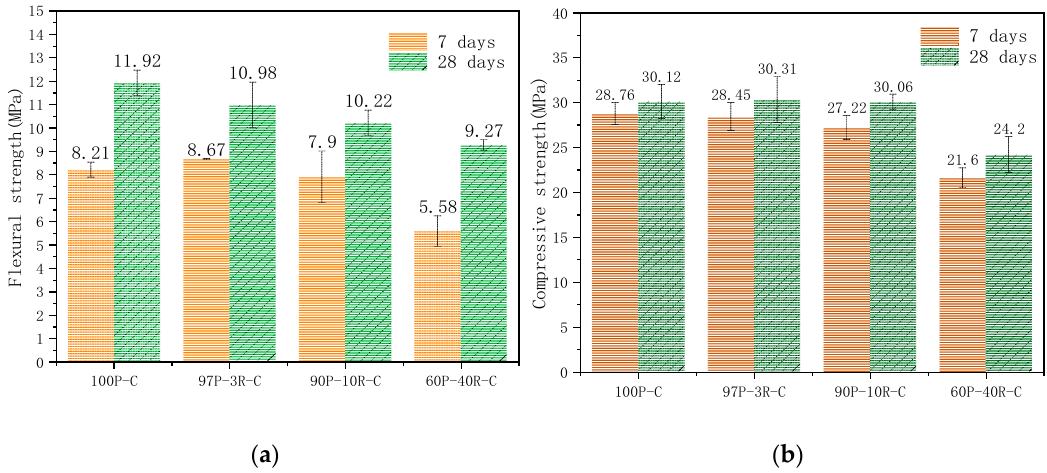
Figure 4. The curve of ( a ) flexural strength and ( b ) compressive strength of concrete prepared with RM partially substituting ordinary Portland cement.